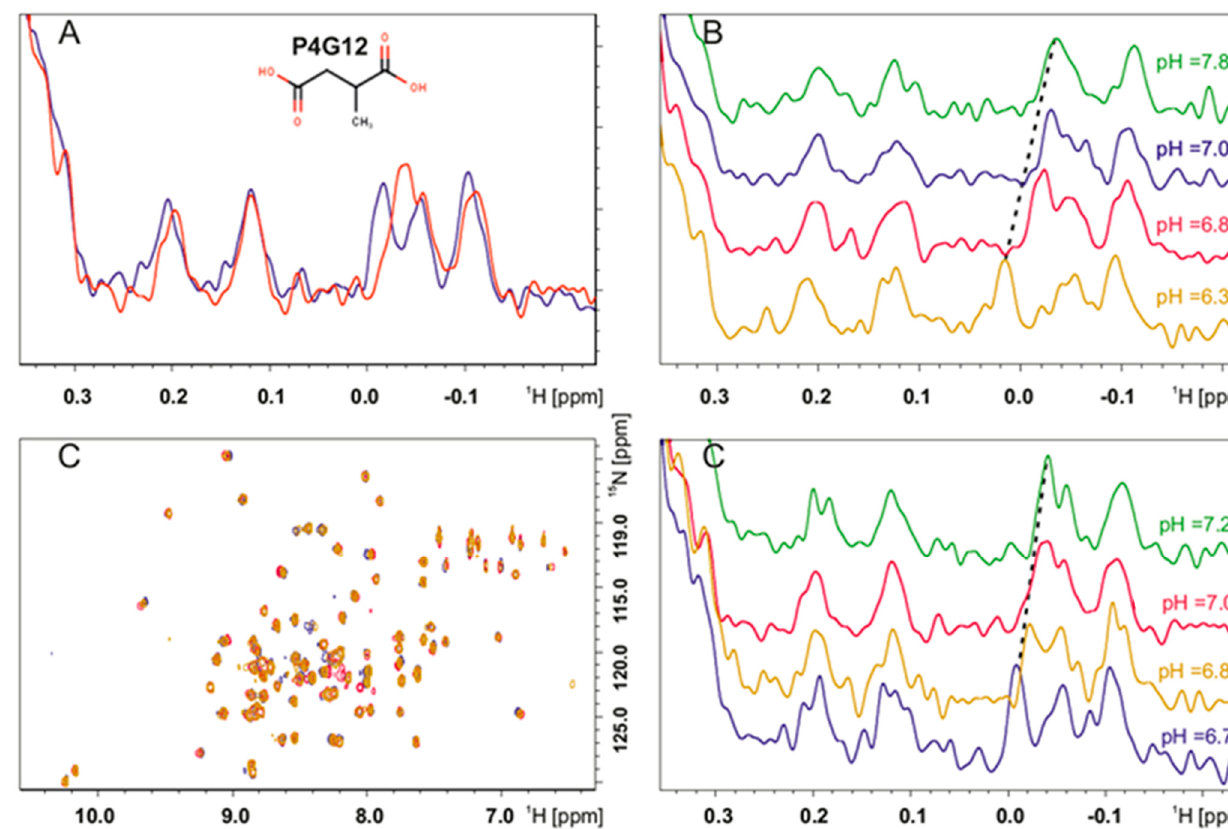
Figure 4. The NMR experiment of the Hub1 protein titrated with small molecular fragments. ( A ) 1 H NMR aliphatic spectrum of reference Hub1 (red) superimposed with the spectrum of Hub1 titrated with 10 − fold excess of P4G12 (blue) indicating a possible interaction of compound P4G12 with the Hub1 protein; ( B ) pH dependence of the aliphatic range of 1 H NMR of the Hub1 protein indicating the sensitive nature of Hub1 to even small pH changes: blue—initial pH of the protein in PBS, red—pH = 6.8; yellow = 6.3; green = 7.8; ( C ) pH correction of Hub1 with the P4G12 small fragment. Left corner — 1 H- 15 N HMQC spectra; right corner —aliphatic 1 H spectrum, red-reference Hub1, blue—after 1:10 addition of P4G12, yellow—pH corrected to 6.8, green—pH corrected to 7.2. Recorded spectra have shown that all changes visible during the titration of Hub1 by P4G12 can be reversed by even small pH changes.